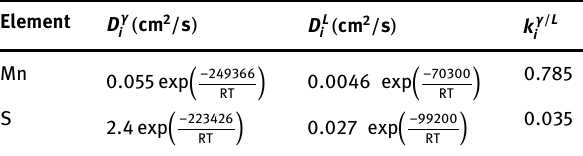
Table 4: Thermodynamic data used for the calculation of